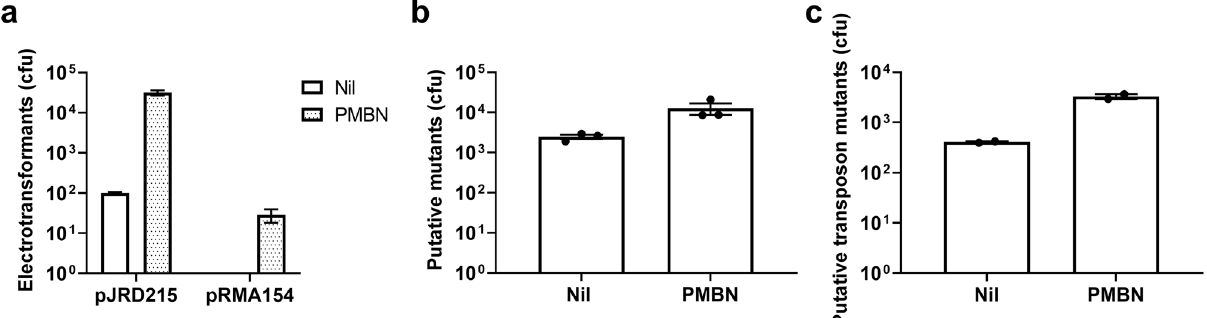
Figure 3. Application of the PMBN electroporation method to improving delivery of large size DNA, mutagenesis rates and TIS library yields in Gram-negative clinical isolates. ( a ) Number of UPEC CFT073 electrotransformants with large plasmid constructs recovered from cultures prepared without (Nil) or with PMBN (1 μg/ml). ( b ) Comparison of putative ΔoafA::cat mutant cfu yields following λ-Red mutagenesis of S. Typhimurium SL1344 electrocompetent cells without (Nil) or with 1 μg/ml PMBN. ( c ) Comparison of putative transposon mutant cfu yields in UPEC UTI89 following standard electroporation without PMBN (Nil) or with PMBN (3 μg/ml) treatment. In all experiments, the starting competent cell density was the same between groups. Data from three ( a , b ) or two ( c ) independent experiments are summarised in graphs showing mean ±